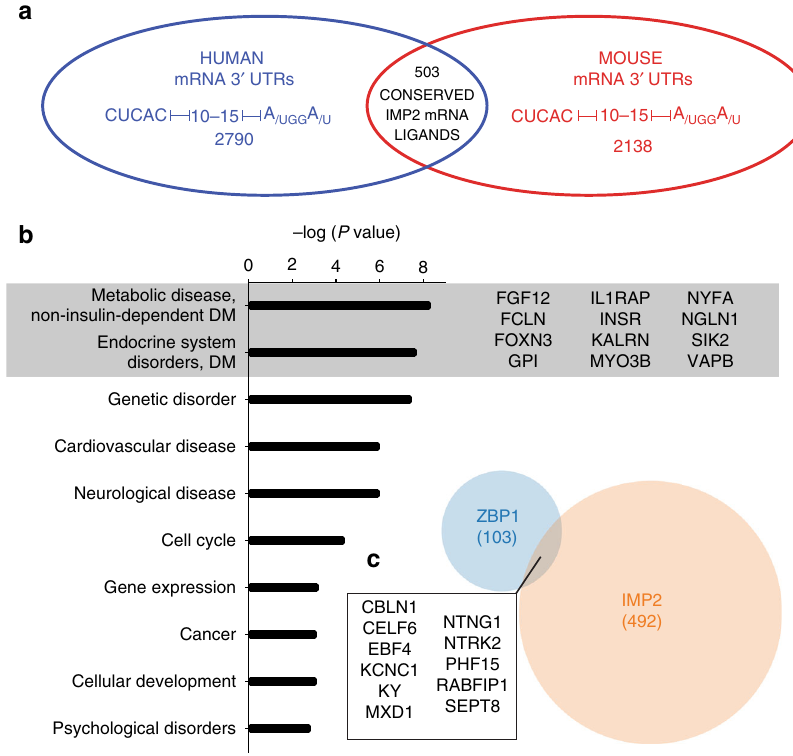
Fig. 6 Genome wide search across 3 ′ UTRs for the IMP2 consensus sequence. a Human and mouse mRNA 3 ′ UTRs containing the IMP2KH34 binding consensus sequences. Conserved RNA targets were used for gene ontology analysis in b . b Gene ontology analysis of conserved mRNA ligands containing the bipartite IMP2KH34 RE. Gray box highlights gene symbols associated with diabetes. c Conserved targets for ZBP1KH34 (blue) and IMP2KH34 (orange) show little overlap. Box highlights gene symbols that are predicted to bind to both ZBP1 and